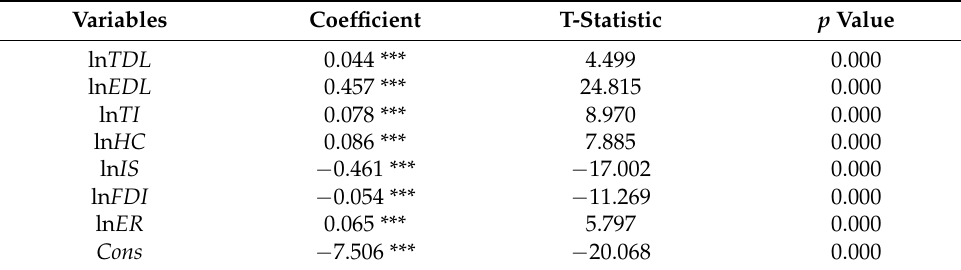
Table 3. Regression results of linear panel data fixed-effects model. Variables